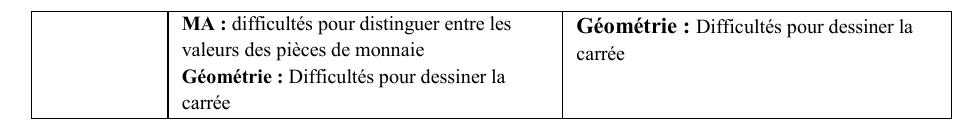
Tableau 3 : Les résultats du pré et du post-test de l’échantillon